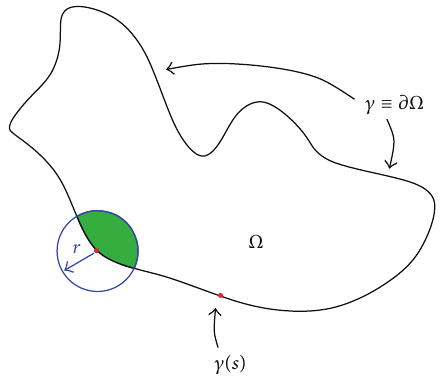
Figure 1: Notation and basic